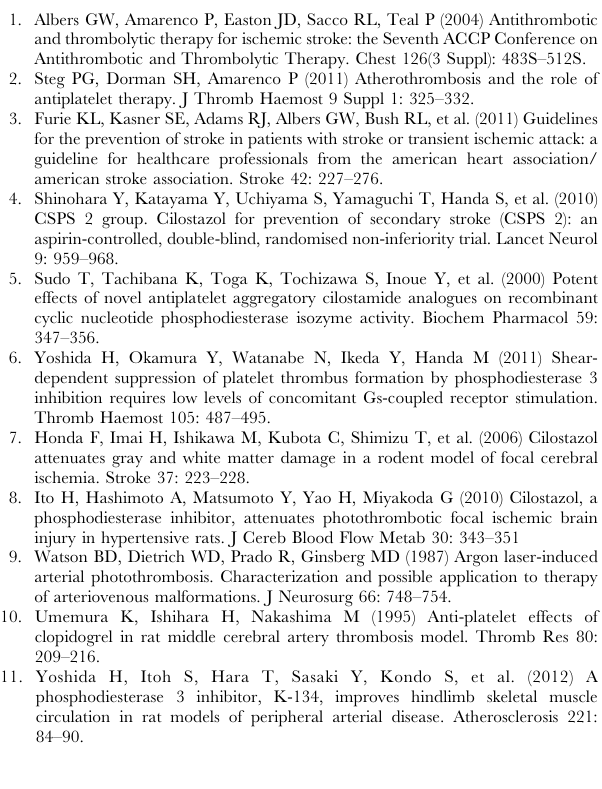
Figure S4 Vasodilatory effects of cilostazol. Vasodilatory effects of cilostazol were evaluated as previously described [11]. Cilostazol was added cumulatively to rat femoral arteries pre- contracted by KCl. Each point represents the mean 6 SEM of percent vasodilation (n= 3). Table S1 Pharmacokinetic parameters of cilostazol and its active metabolites (OPC-13015 and OPC-13213) in rats. Table S2 Plasma concentration of K-134 in mice. vivo antiplatelet effects study, vasodilation study and bleeding time